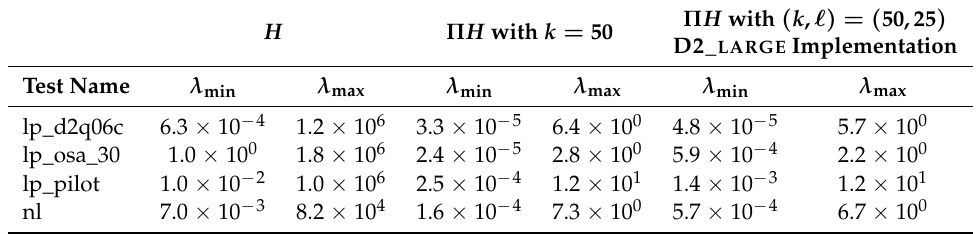
Table 4. Minimum eigenvalue λ min and maximum eigenvalue λ max of: matrix H , matrix Π H with